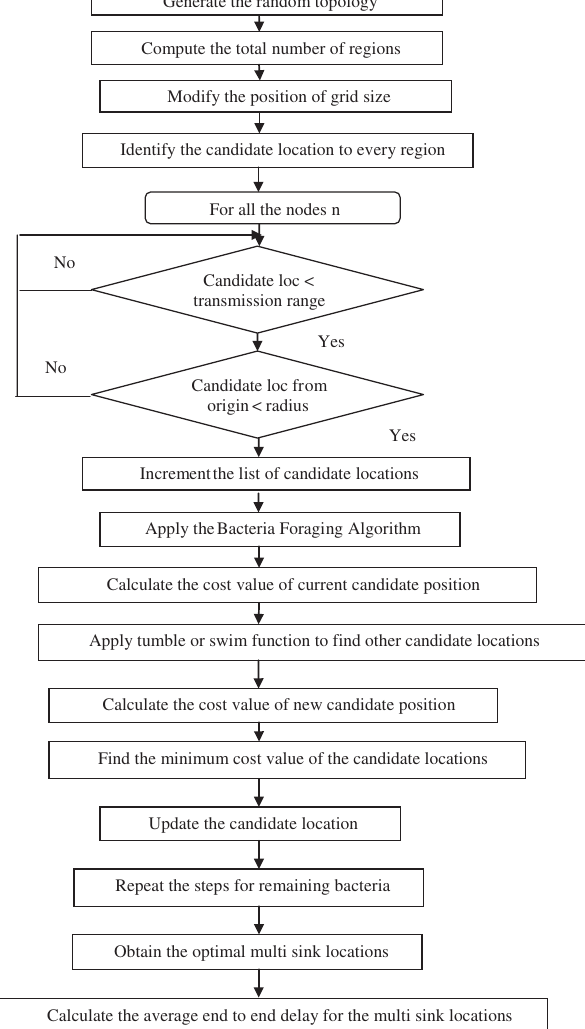
Figure 4: Flowchart for Optimal Multi Sink Placement Using BFA.